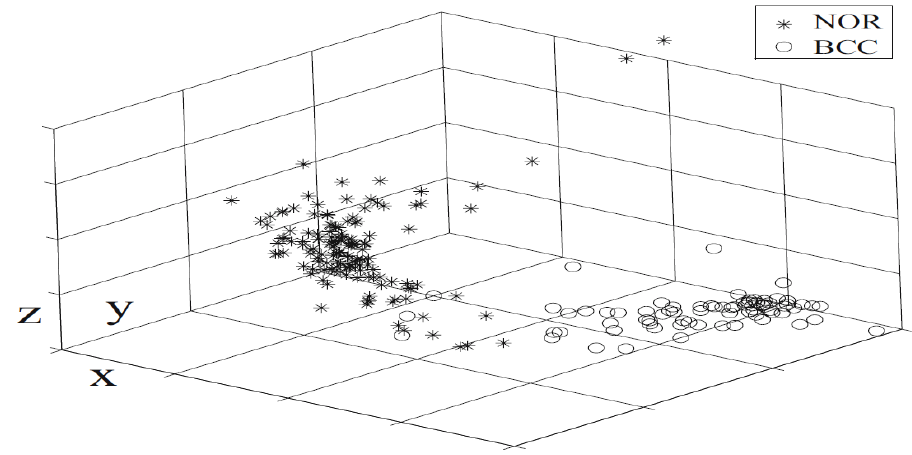
Figure 12. Distribution of the first three components of PCA transformed spectra (of biopsy samples from 10 patients) ©